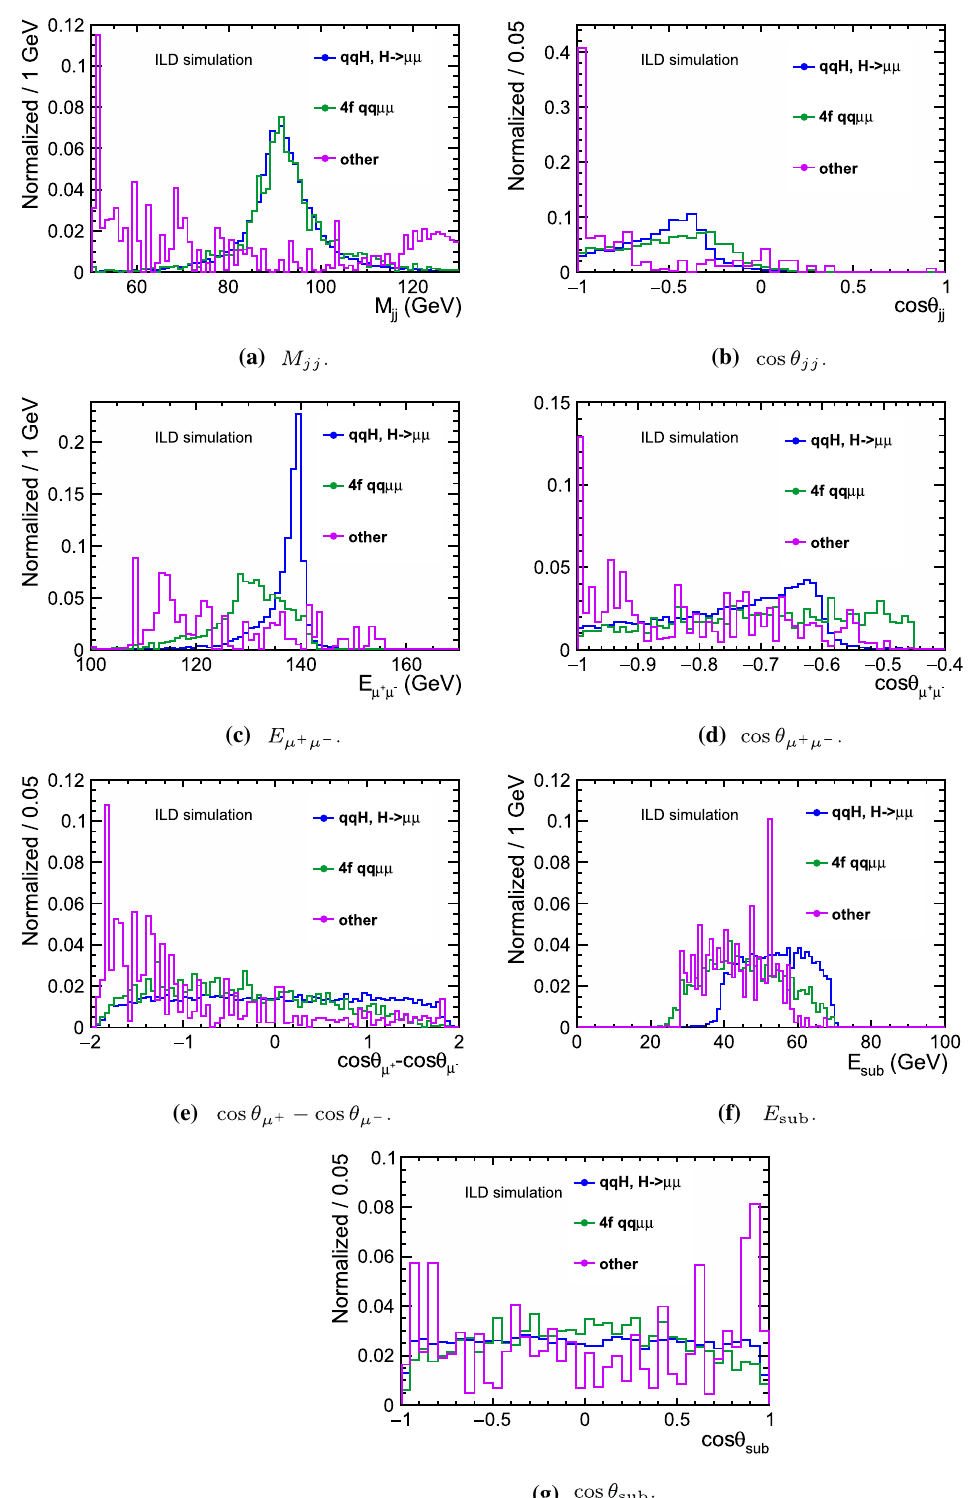
Fig. 5 Example input variables for the BDTG in qqH250-L. All histograms are normalised to an integral of 1. The signal process is shown in blue, the irreducible backgrounds are contained in the green histograms, while other backgrounds are shown in